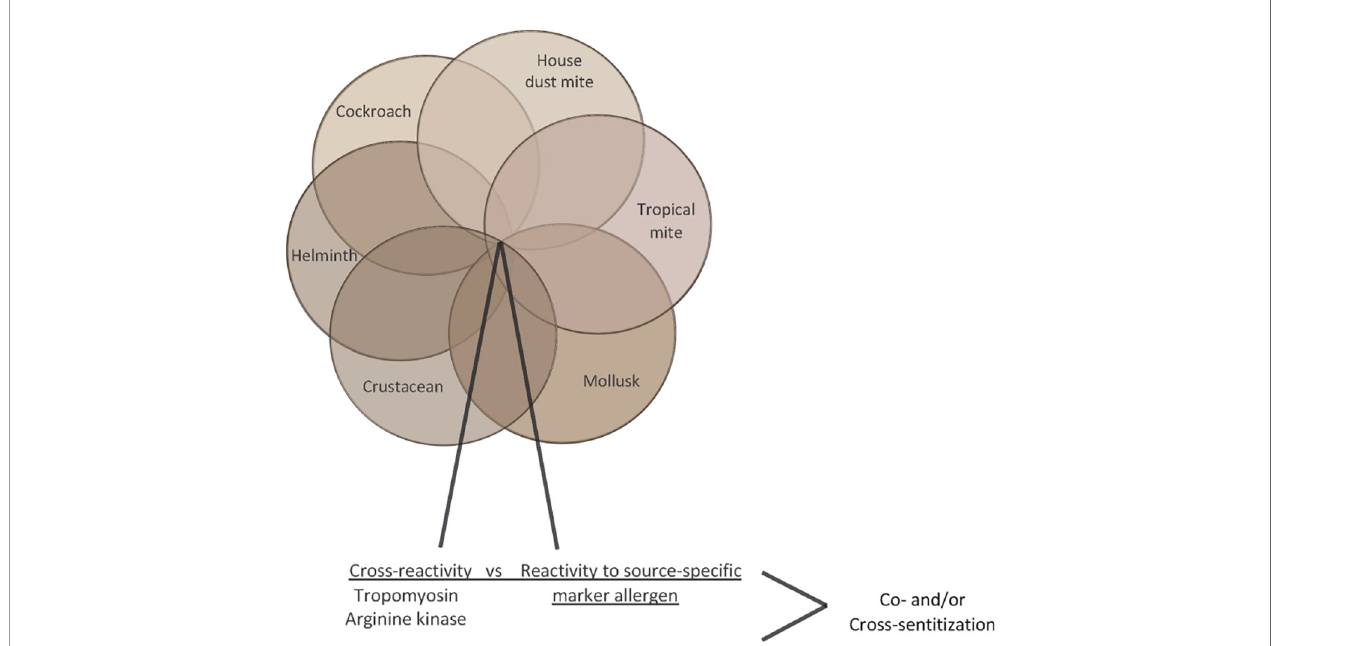
FIGURE 6 | Venn diagram of invertebrate allergen sources (house dust mites, tropical mites, cockroach, crab, shrimp) indicating cross-reactive allergens (tropomyosin, arginine